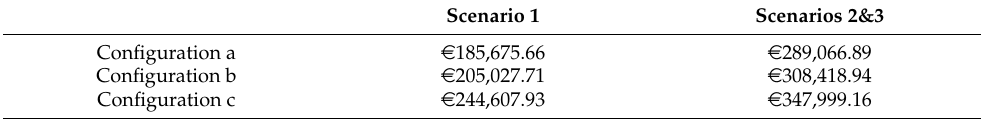
Table 6. Initial investment per